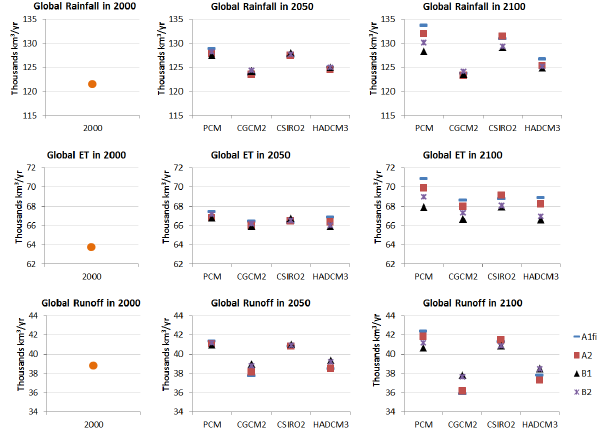
Figure 5: Comparison of annual precipitation, actual ET, and runoff estimates across GCMs and emission scenarios in years 2000, 2050, and 2095; uncertainty across GCMs is larger than scenarios, and the uncertainty level increases with time, i.e., uncertainty is larger in 2100 than 2050